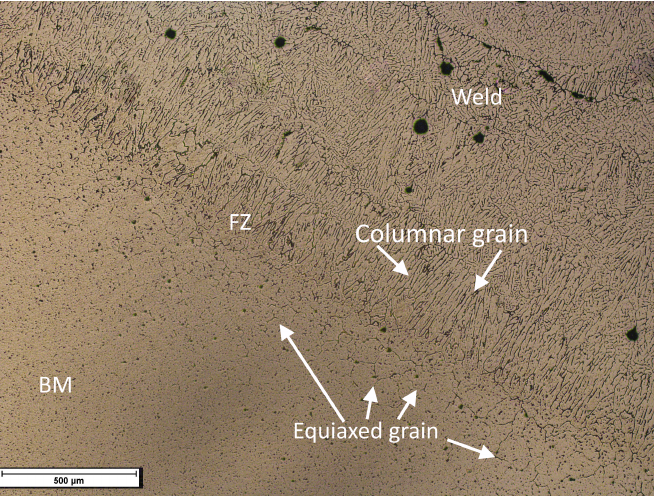
Figure 11. Heterogeneous grains in different zones of the weld